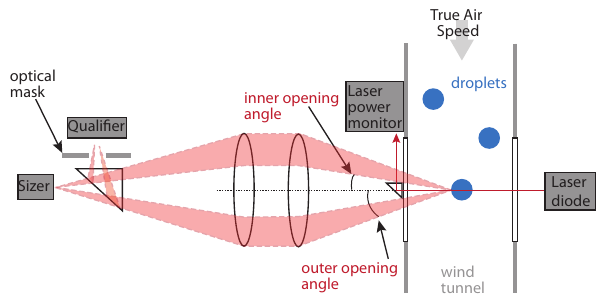
Fig. 2. Schematic view of the theory of operation of the FM-100 (modified from Droplet Measurement Technologies, 2011). Cloud droplets (blue dots) are pulled through the wind tunnel at constant speed (True Air Speed=TAS) and pass the laser beam. The scat- tered light (red) from the particle is directed through the optical system and then detected by the qualifier and sizer. The inner and outer opening angle depend on the individual instrument and the position where exactly the droplet passed the laser